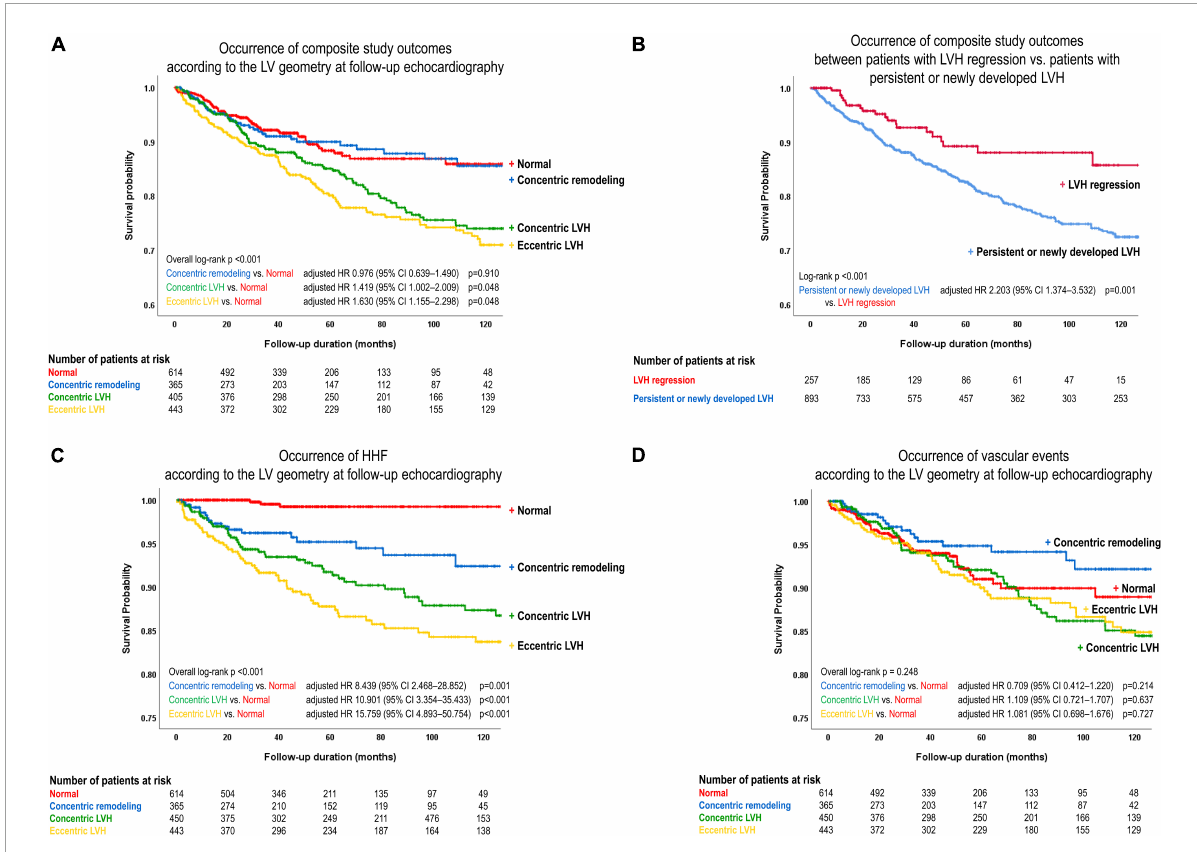
FIGURE4 Event-free survival curves. The risk of the composite study outcome was compared (A) according to the LV geometry at follow-up echocardiography, and (B) between patients with LVH regression at follow-up echocardiography and those with persistent or newly developed LVH. The risk of (C) HHF and (D) vascular events was compared according to the LV geometry at follow-up echocardiography. LVH, left ventricular hypertrophy; HR, hazard ratio; CI, confidence